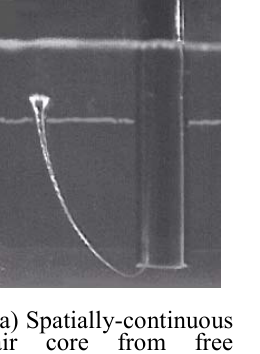
(b) Spatially-intermittent air core from free surface to a pipe